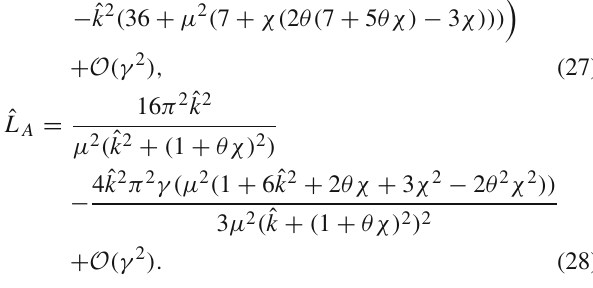
same as for the typical axions model and are independent of the two-currents model